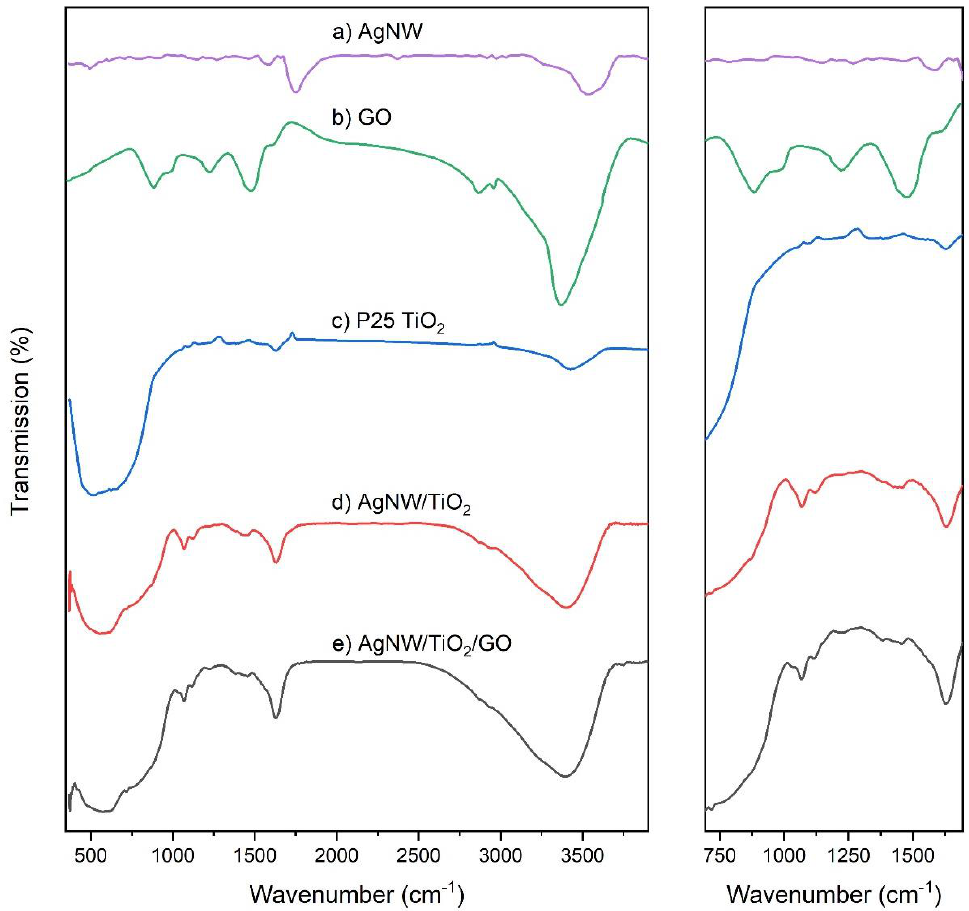
Figure 7. FTIR spectra of ( a ) AgNW, ( b ) GO, ( c ) P25 TiO 2 , ( d ) AgNW/TiO 2 , and ( e ) AgNW/TiO 2 /GO samples.